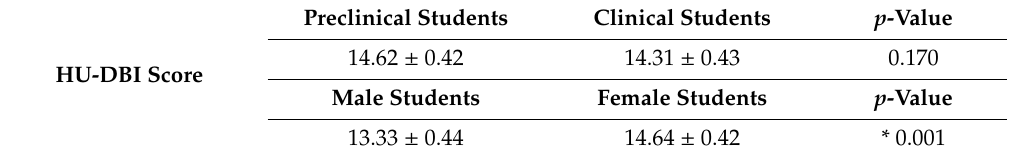
Table 5. HU-DBI Scores of preclinical / clinical and male / female dental